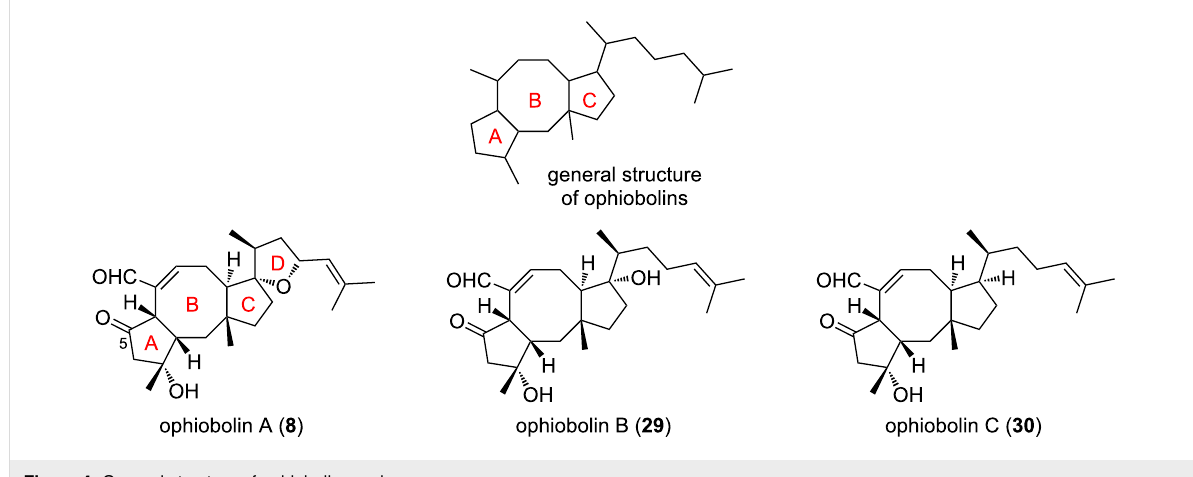
Figure 4: General structure of ophiobolins and congeners.